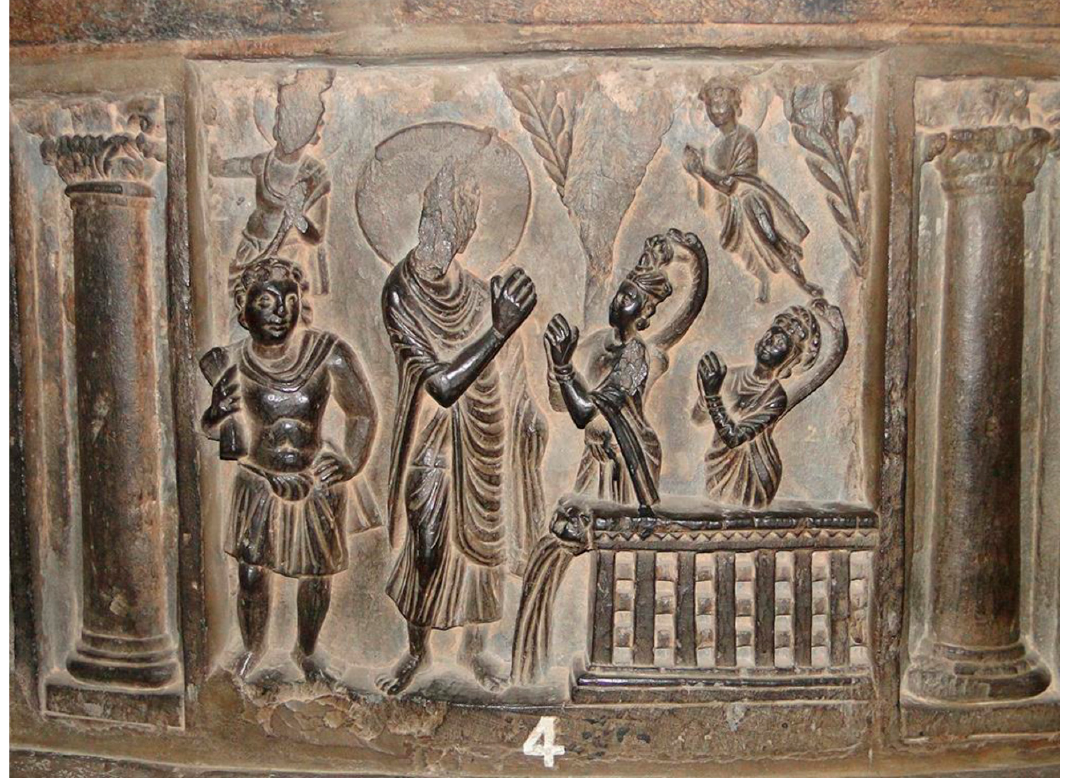
Figure 1. Gandhara, Sikri, Lahore Museum, no. 1277, G-6 © photograph Muhammad Hameed.